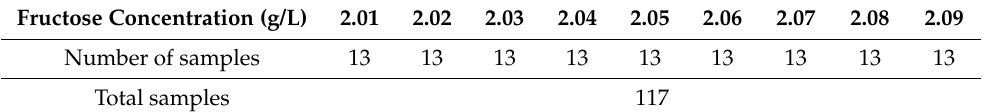
Table 3. Number of samples and their composition used in the experiment. A total of 117 samples of distilled water with different concentrations of fructose, in the range of 2.01 g/L to 2.09 g/L, were